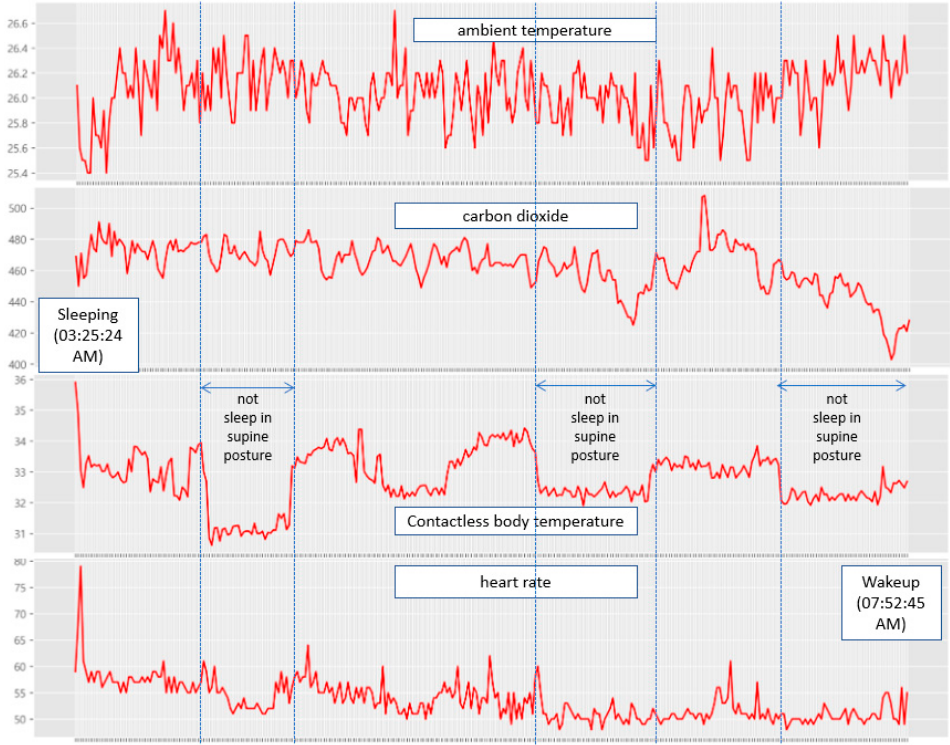
Figure 24. Sleep pattern measurement results of the 56-year-old woman.